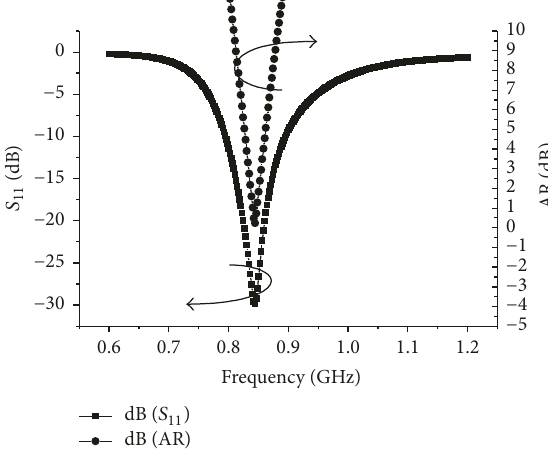
Figure 2: Axial ratio and return loss of the proposed